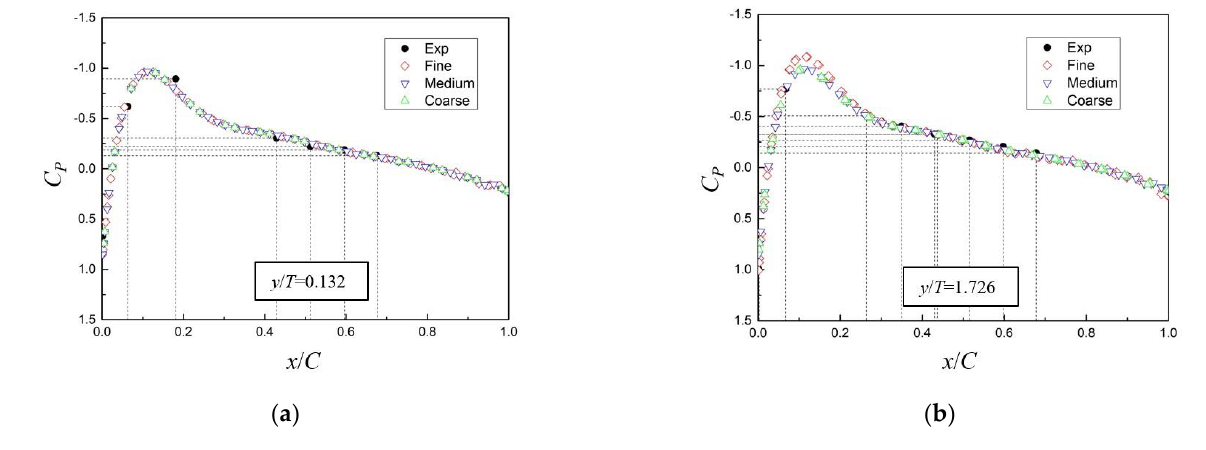
Figure 2. Mean C p calculated by SLA-IDDES: y / T = ( a ) 0.132 and ( b ) 1.726.